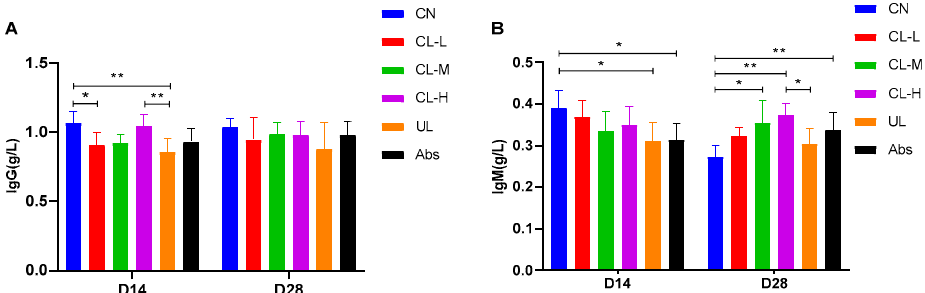
Figure 2. Effects of the CL-L, CL-M, CL-H, UL and Abs dietary interventions on serum immunoglob- ulins. ( A , B ) represent IgG and IgM, respectively. The data are presented as the means ± SE ( n = 6). * indicates significant differences ( p < 0.05), ** represents very significant differences ( p < 0.01).